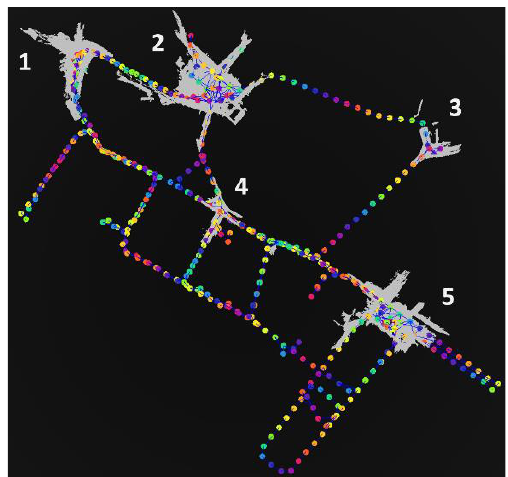
Figure 7. Planimetric view of the position of the five scans acquired with TLS Leica HDS-7000.